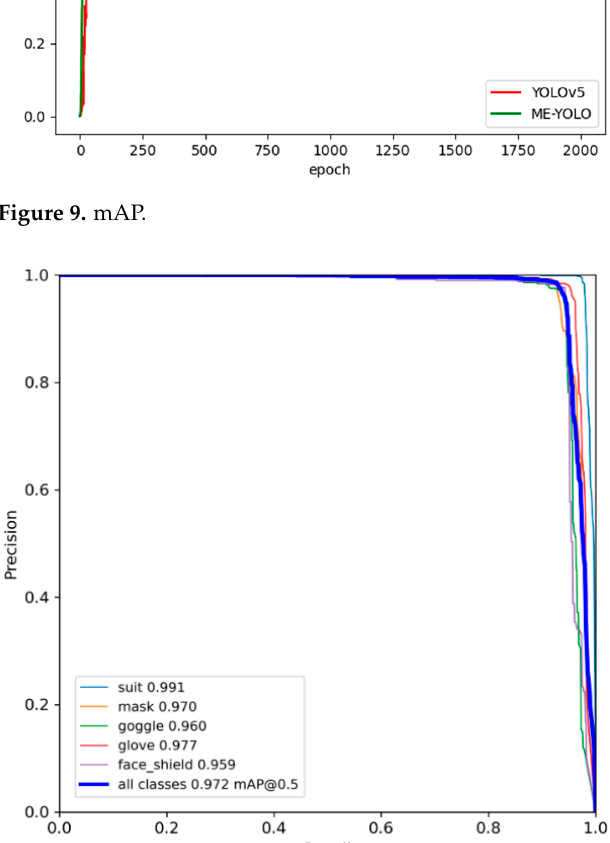
Figure 10. PR curve. The larger the area under the PR curve, the better the performance of the model.